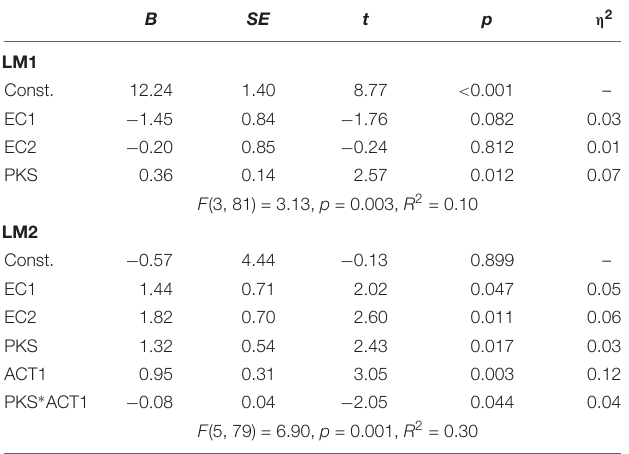
TABLE 9 | Regression results for LM1 and LM2, Study 2.